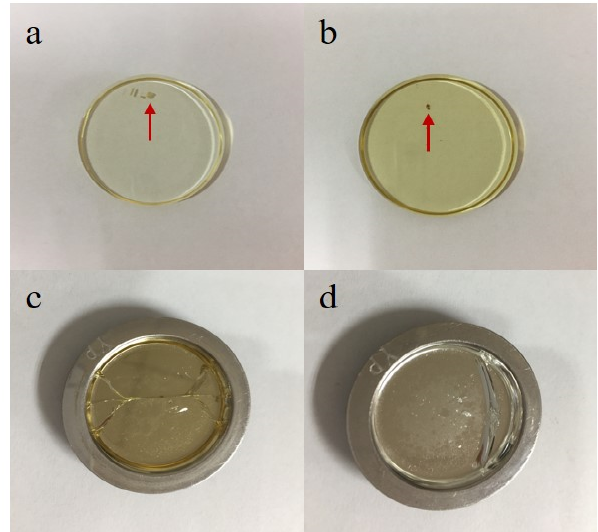
Figure 3. Fused glass discs prepared by the stirring rod (ST) method (letters ( a ) and ( b ) represent the fused glass discs with crystallization spots; letters ( c ) and ( d ) represent the cracked glass discs).